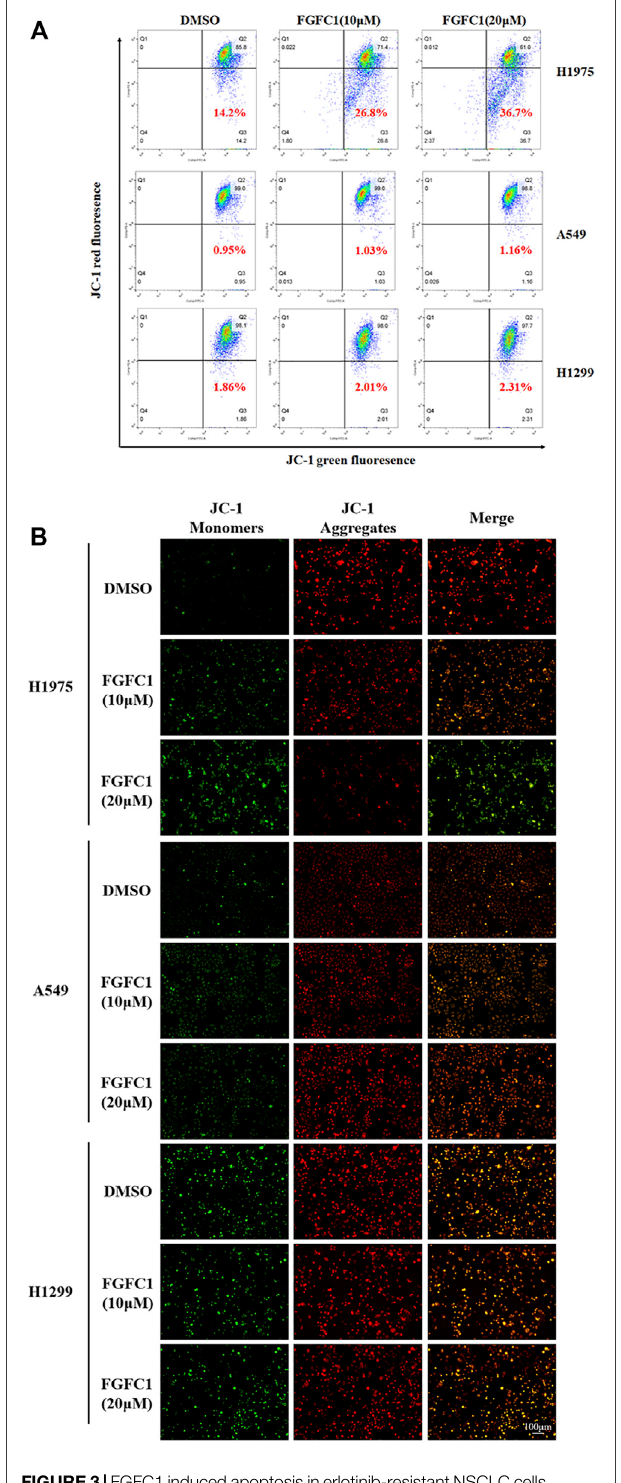
FIGURE3| FGFC1inducedapoptosisinerlotinib-resistant NSCLC cells via mitochondrial dysfunction and accumulation of ROS. (A) FGFC1 signi fi cantly downregulated the MMP level. H1975, A549 and H1299 cells were treated with FGFC1 at different concentrations (0, 10 and 20 μ M) for 24 h. The treated cells were stained with JC-1 dye and then analyzed by